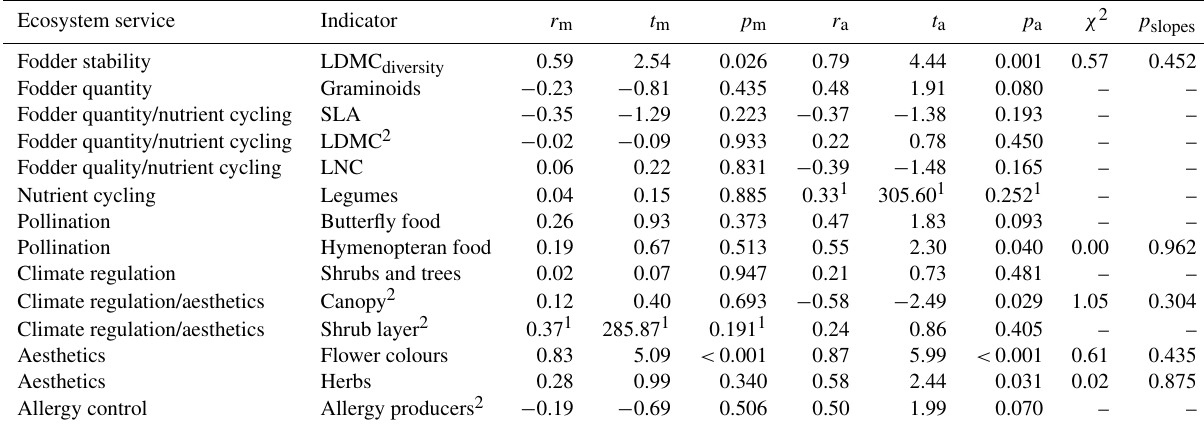
Table 4. Different relationships between plant species richness and ecosystem service (ES) indicators in extensively managed (m) and abandoned (a) semi-natural grasslands. The correlation ( r ) between plant species richness and ES indicators, the test statistics ( t ), and significance of the correlation ( p ) based on Pearson or Spearman 1 correlation tests and the test statistics ( χ 2 and p slopes ) of likelihood ratio tests that compare the relationships (slopes of standardized major axis models) in the two land use